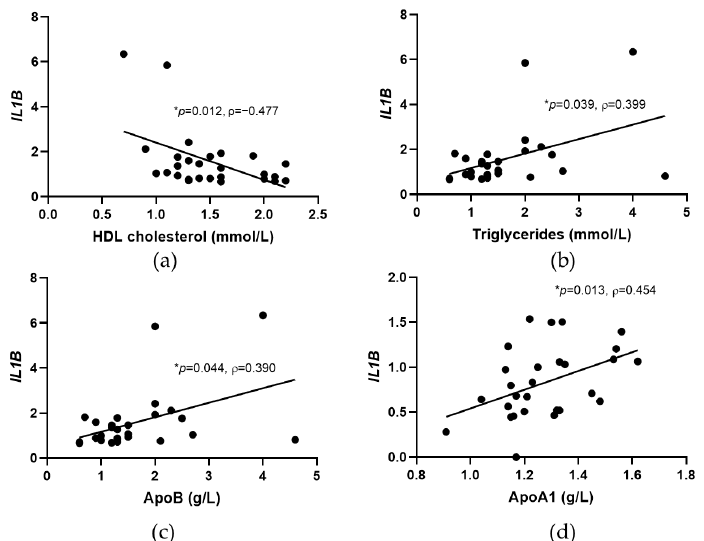
Figure 3. Significant correlations between IL1B expression and lipid parameters. Significant correlations were found between IL1B and HDL cholesterol ( a ), triglyceride levels ( b ), and apolipoprotein B (ApoB) ( c ) in healthy controls, and between IL1B and apolipoprotein A1 (ApoA1) ( d ) in patients with CAD prior treatment with PCSK9 inhibitors. Scatter plots are shown with the results of Spearman correlation analysis (* p < 0.05; ρ , Spearman ’ s correlation coefficient). Gene expression data are normalized to geometric mean of glyceraldehyde-3-phosphate dehydrogenase ( GAPDH ) and ribosomal protein L13a ( RPL13A ).